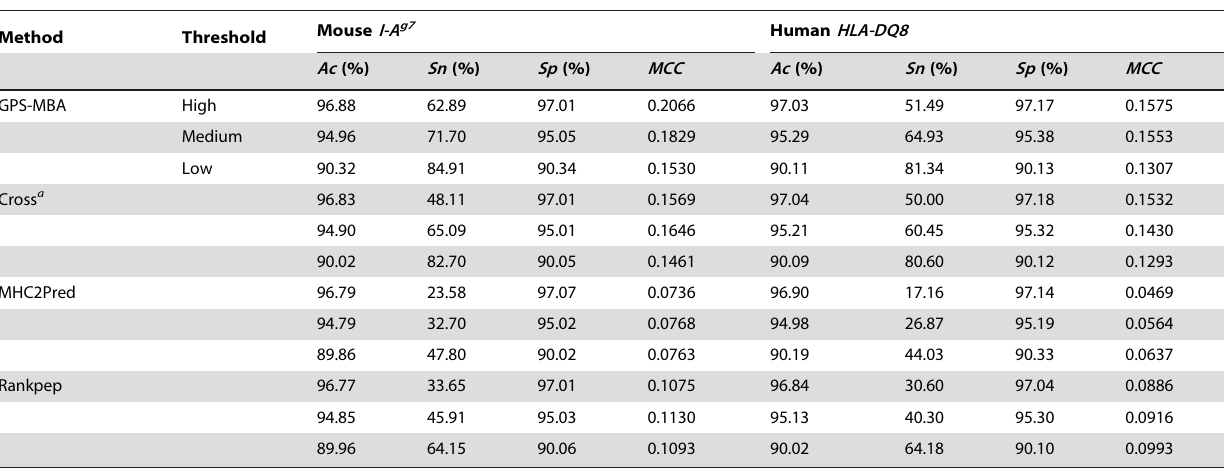
Table 2. Comparison of GPS-MBA 1.0 with other approaches.